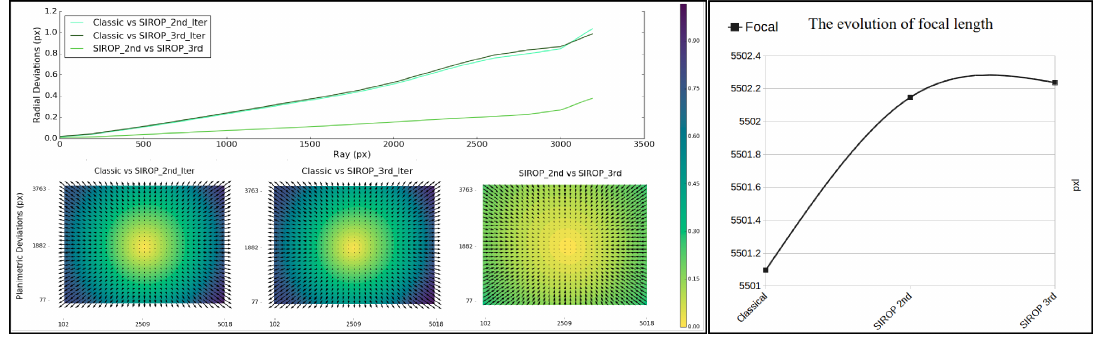
Figure 29. The evolution of internal camera parameters in Corridor after second and third SIROP iteration. ( Left ): The radial distorsion. ( Right ): The camera focal length.